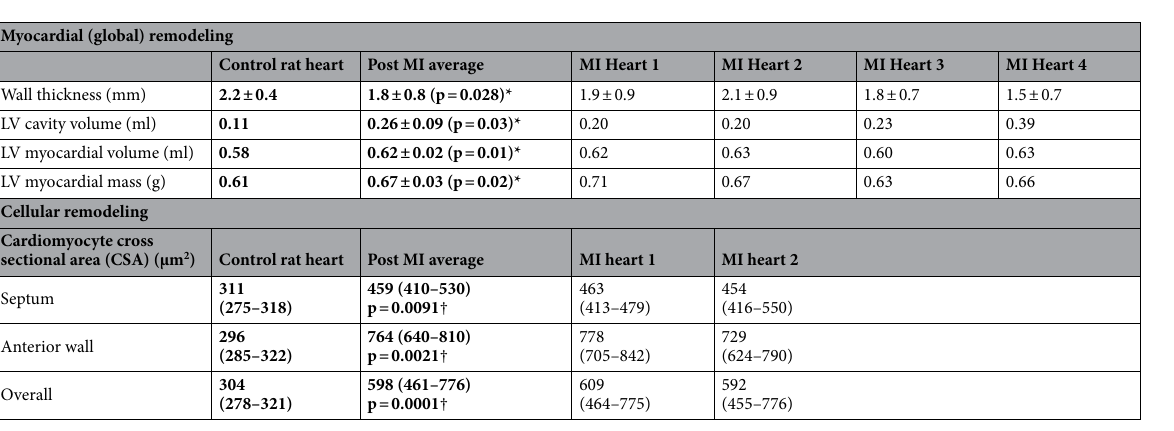
Table 1. Parameters and quantification of global and cellular LV remodeling obtained by PB X-PCI imaging. Normally distributed continuous variables are presented as means with standard deviations, and non-normally distributed as medians with interquartile range. Upper panel: LV wall thickness is averaged over 45 segments for each animal. Lower panel: CSA is averaged from 10 cardiomyocytes per region. LV left ventricle, MI myocardial infarction. *Comparisons of means between post-MI hearts (N = 4) and the healthy heart (N = 1) with a two-tailed Student’s T test. † Significant difference in CSA overall and between similar myocardial areas of affected and non-affected hearts (post-MI hearts N = 2, healthy heart N = 1), compared by a Kruskal Wallis non-parametric